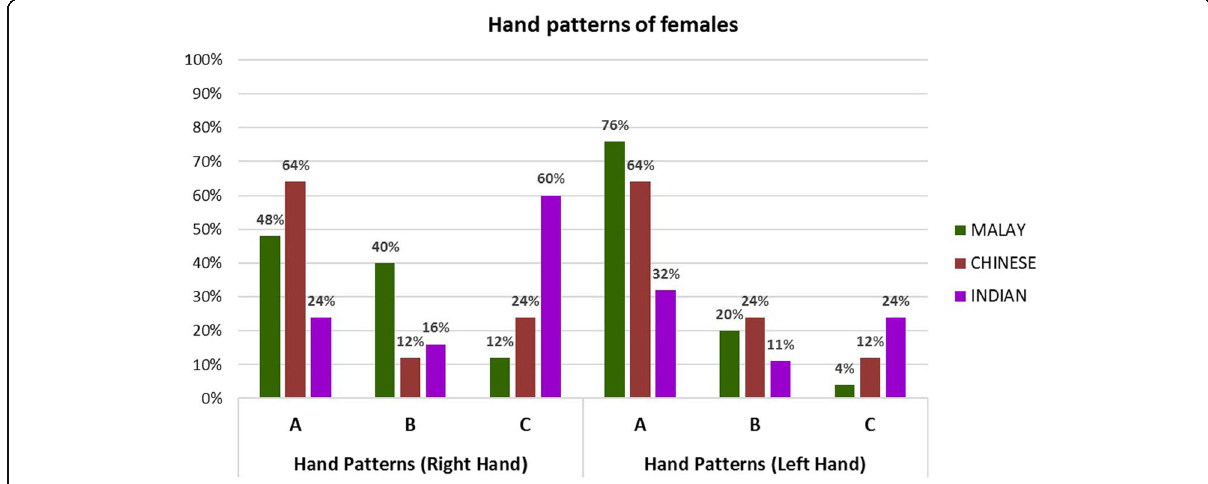
Fig. 3 Graph showing the percentage distribution of hand patterns of females between the three